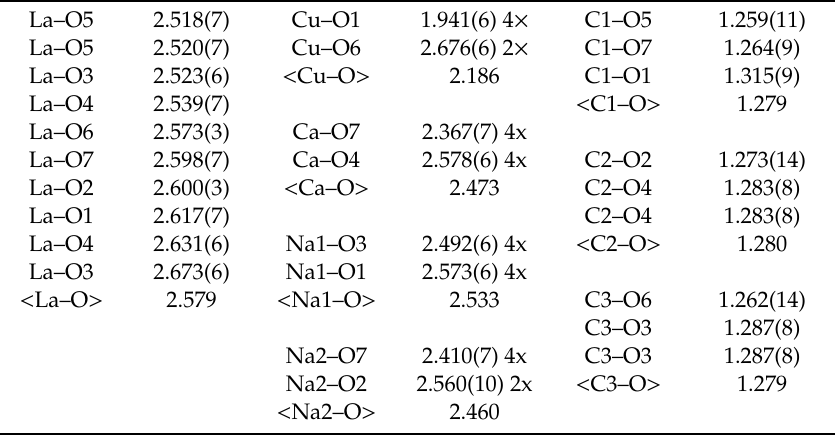
Table 5. Selected bond lengths (Å) in the crystal structure of paratooite-(La).